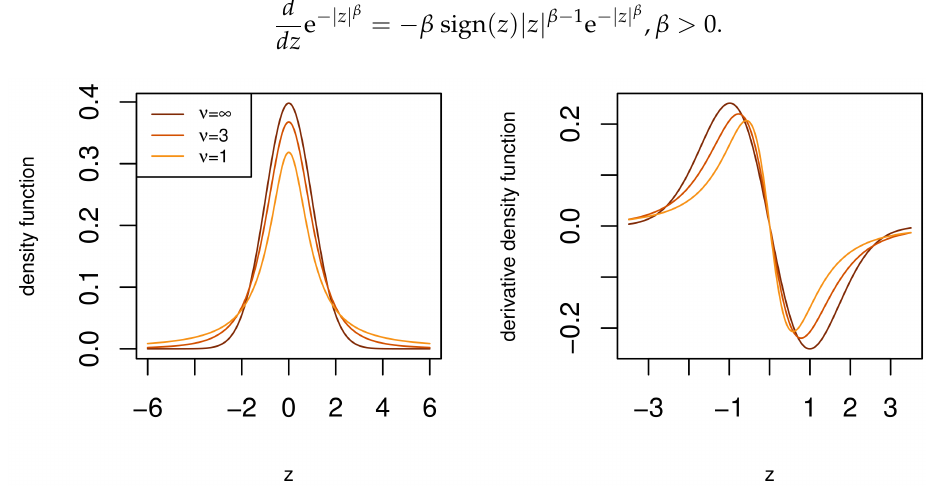
Figure 2. The density and derivative density functions of the t-distribution. Note the different density derivative function magnitudes at the body and tail for lighter and heavier